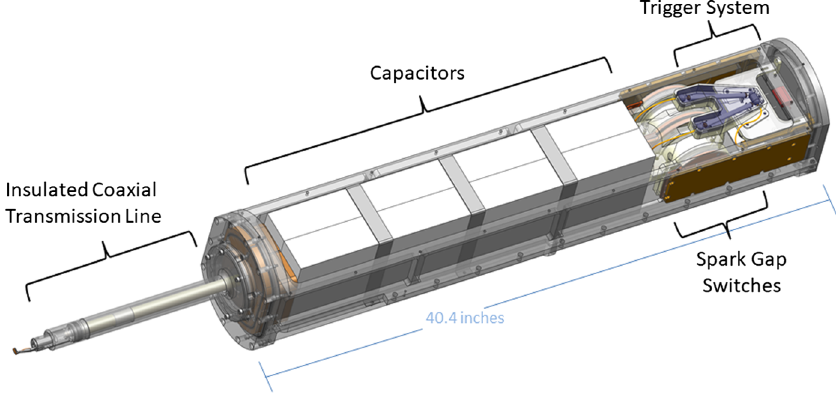
FIG. 1. MIFEDS-III design